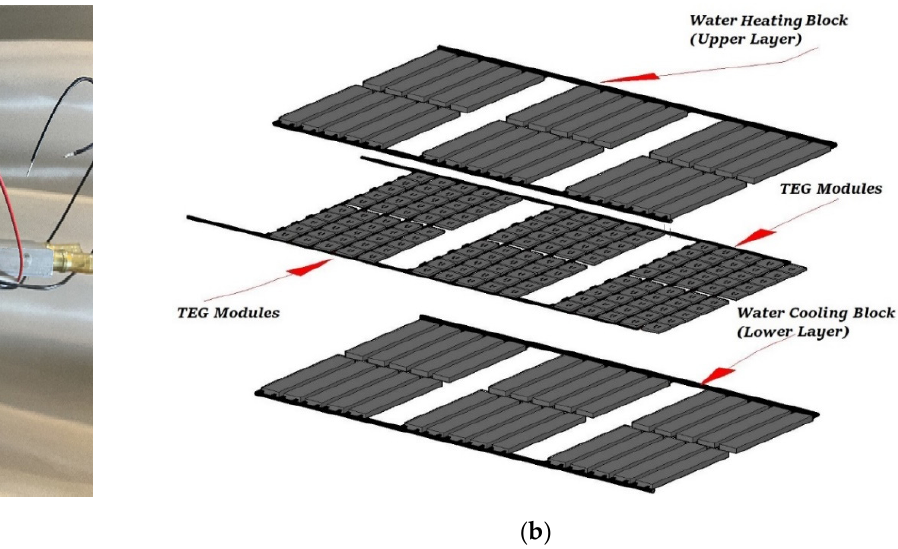
Figure 3. ( a ) Single line of layer panel, and ( b ) Schematic diagram of a 15 × 10 TEG panel. The processing system consists of three Sections . Section 1 represents the hot surface